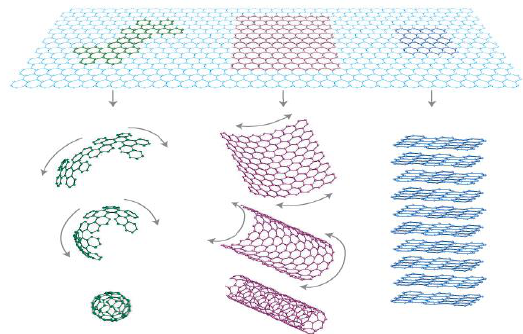
Figure 8. Graphene is the fundamental structural units for other carbonaceous materials (0-D fullerenes, 1-D CNTs and 3-D graphite) (reprinted from Ref. [72] with permission from Nature Publishing Group).